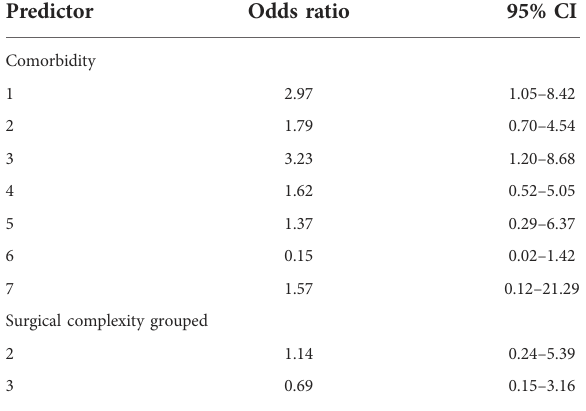
TABLE 6 Logistic regression table. TABLE 7 POI and